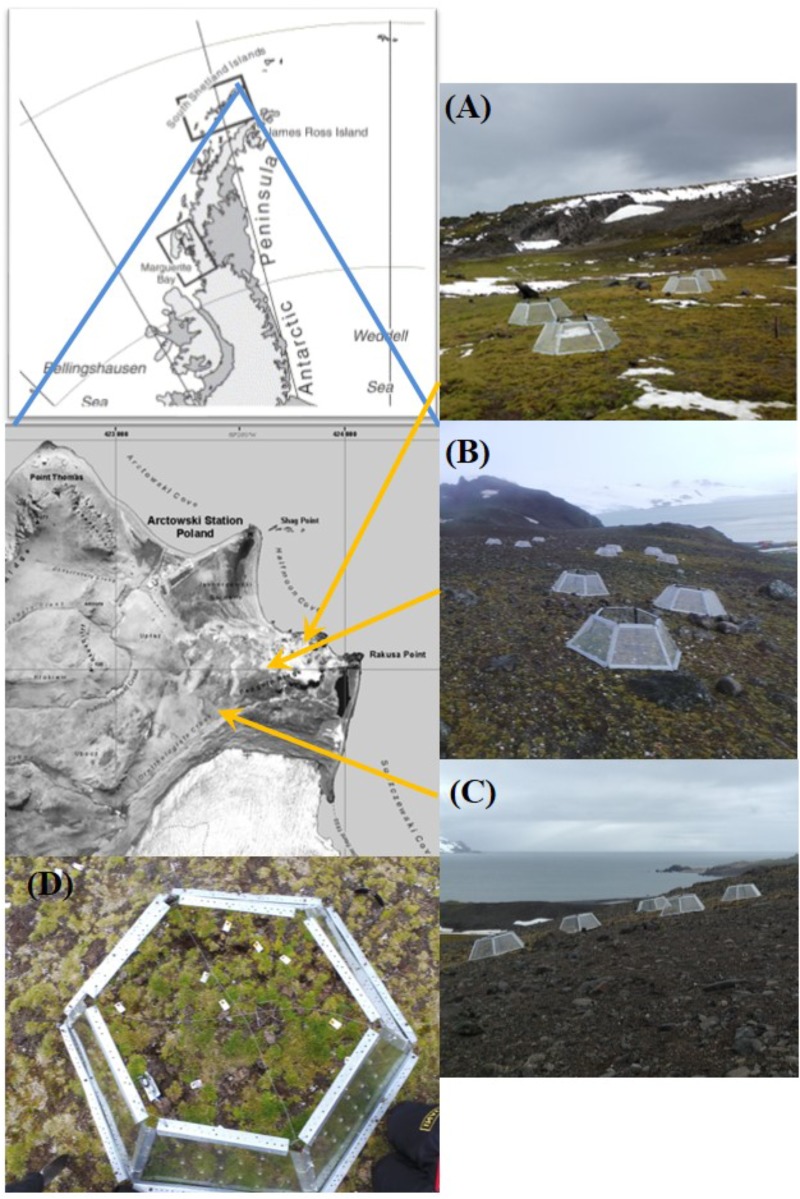
Study area in the King George Island (South Shetland Archipelago) where experimental warming was installed. Photographs correspond to (A) Site 1, nearest the beach; (B) Site 2, and (C) Site 3; (D) showed several individuals of C. quitensis inside an OTC (see Materials and Methods sections for site descriptions and experimental design).